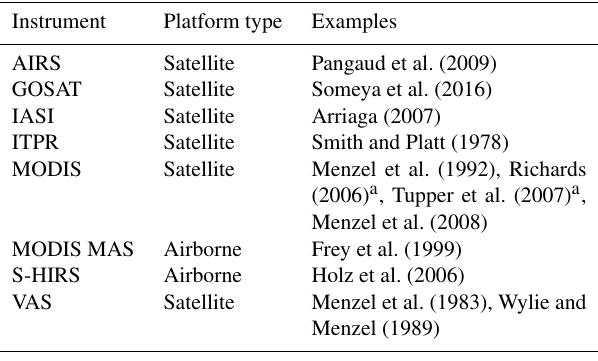
Table 2. A summary of some of the previous applications of the CO 2 slicing